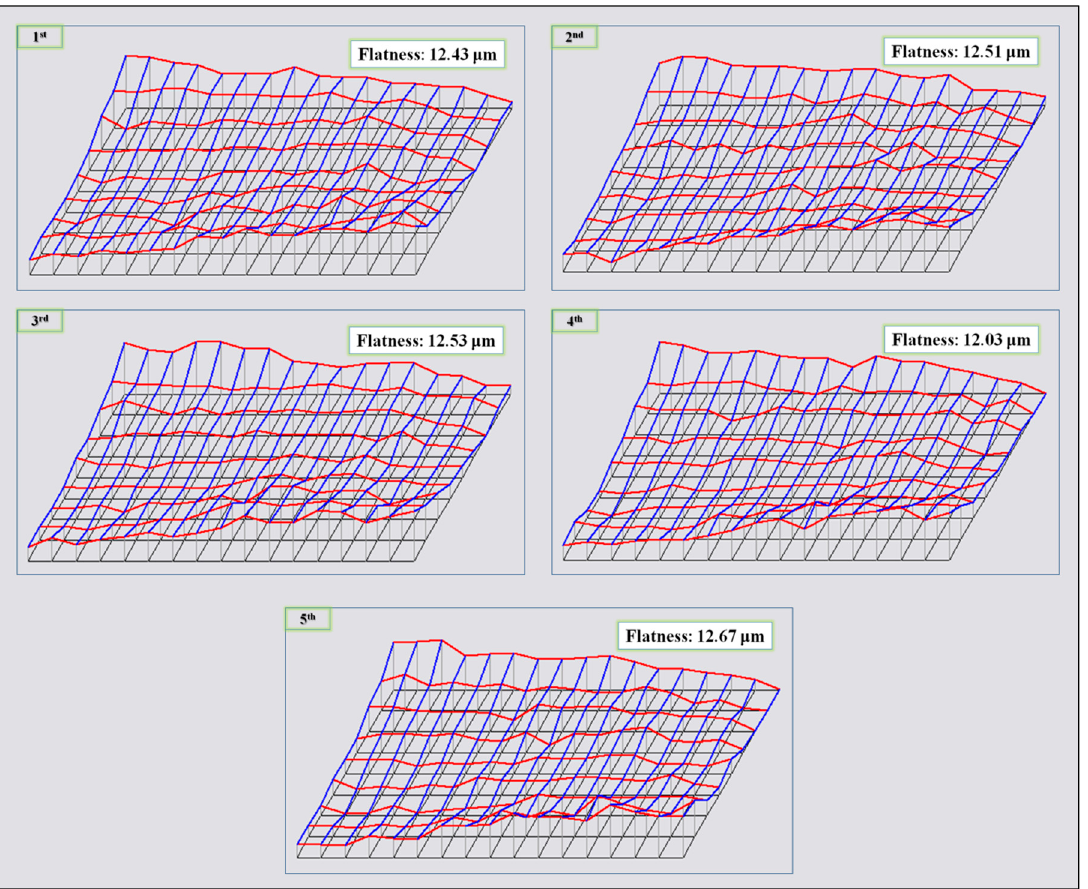
Figure 16. Vertical straightness error distribution and corresponding flatness of the X-Y plane.